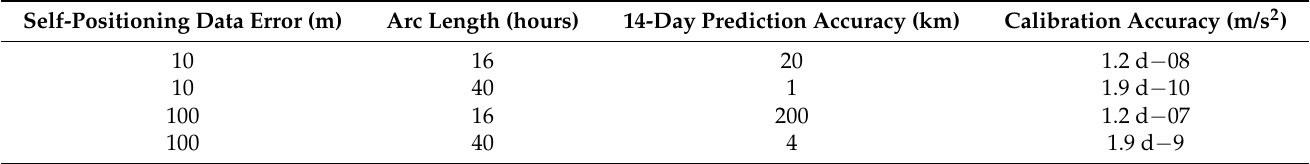
Table 8. Analysis of 14-day prediction and calibration